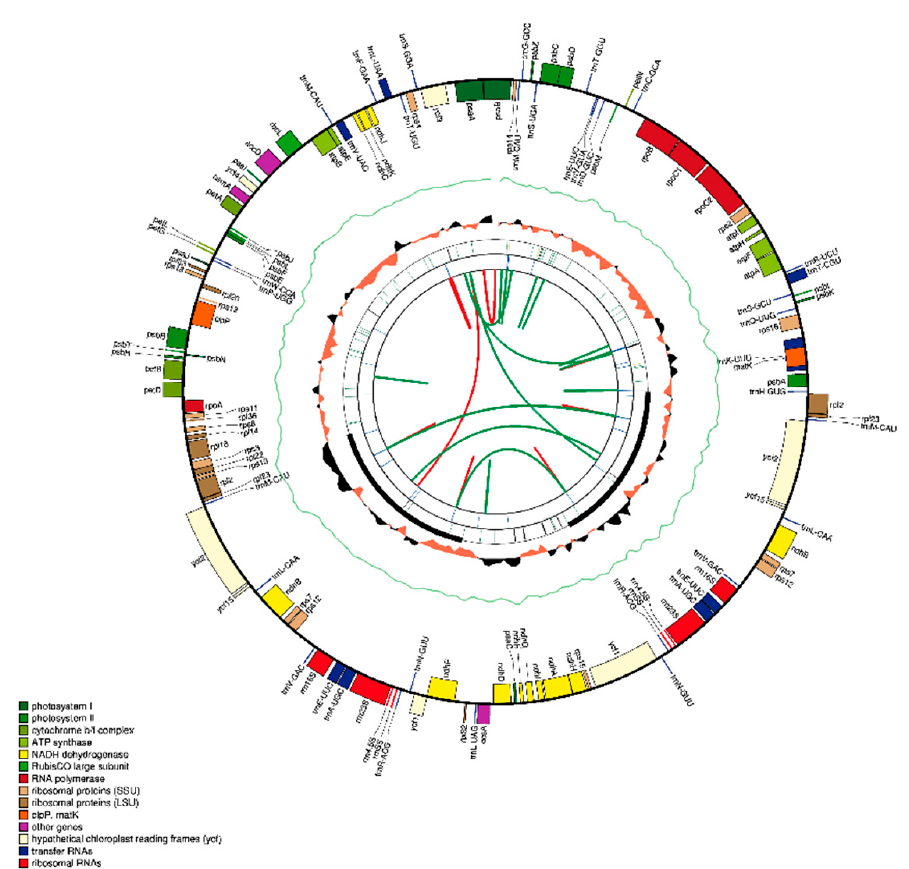
Figure 2. Consensus circular genome map of Withania plastomes. The first larger ring represents the gene structure of the chloroplast genome. The GC content is plotted as a green line while a skewed GC plot is presented as an orange/black track around the inner circles. The second ring is displaying the IRs as longer black boxes, while tandem repeats are represented by short bars. The third, and last circle shows the output of MISA microsatellite detection, where reverse repeats are connected with green arcs, while red arcs represent forward repeats.